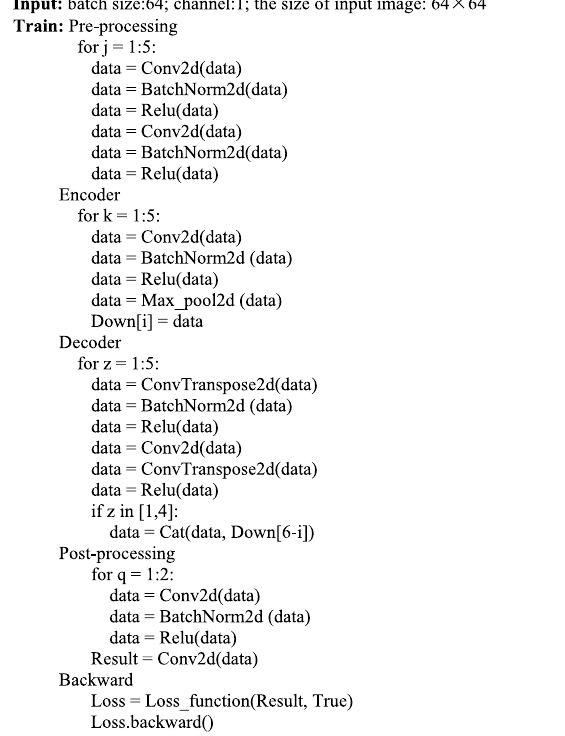
TABLE 1 DC-Net algorithm. Algorithm: Convolutional upscale